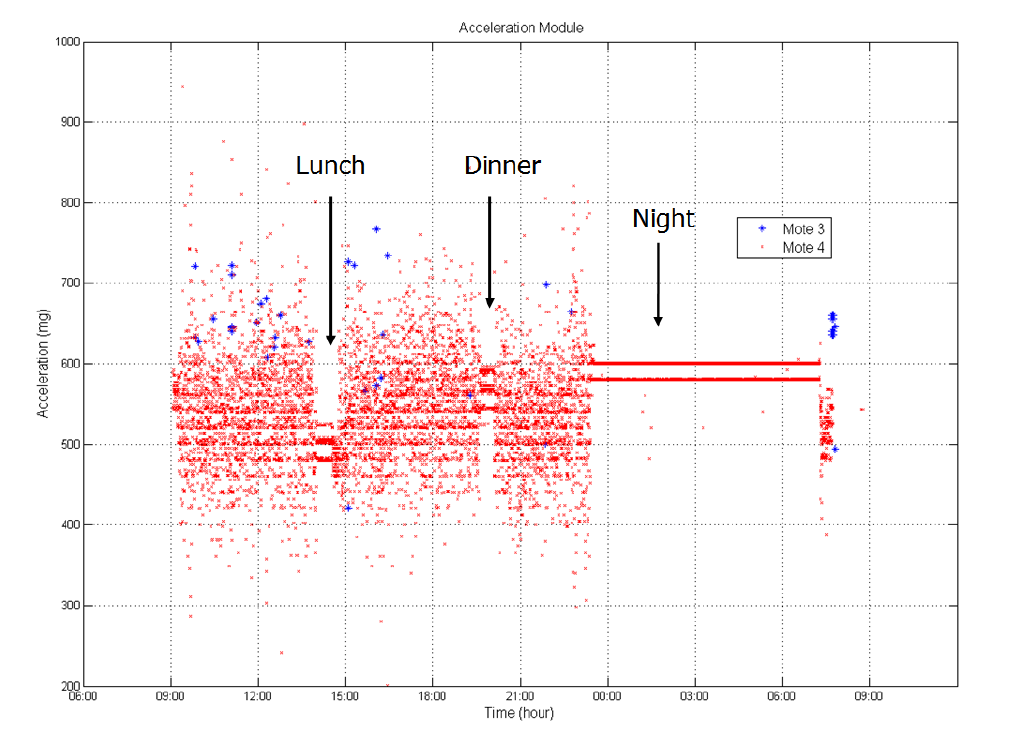
Figure 6. Acceleration module for the two